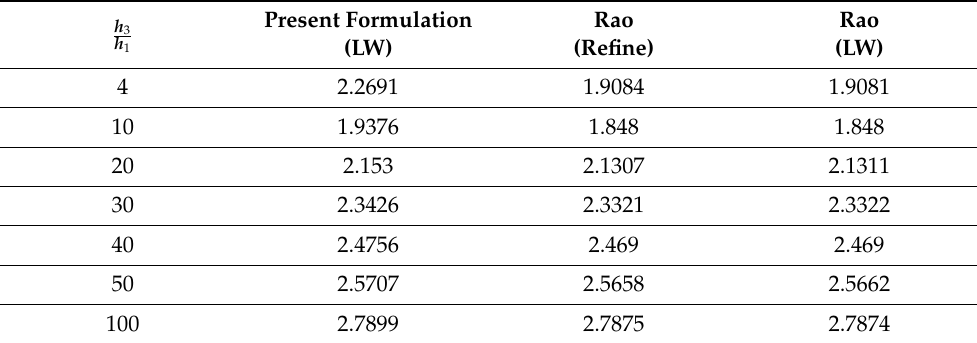
Table 4. Comparison of non-dimensional fundamental frequencies ω of (0 ◦ /90 ◦ /core/0 ◦ /90 ◦ ) = = 1 and h 3 sandwich plate with a h 1 b